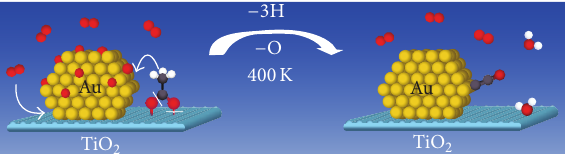
Figure 2: This shows the conversion of acetate to ketenylidene at the perimeter site of the Au/TiO 2 catalyst. The acetate, which adsorbs on TiO 2 , undergoes dehydrogenation (oxidation) and the deoxygenation to form ketenylidene on the gold [60].